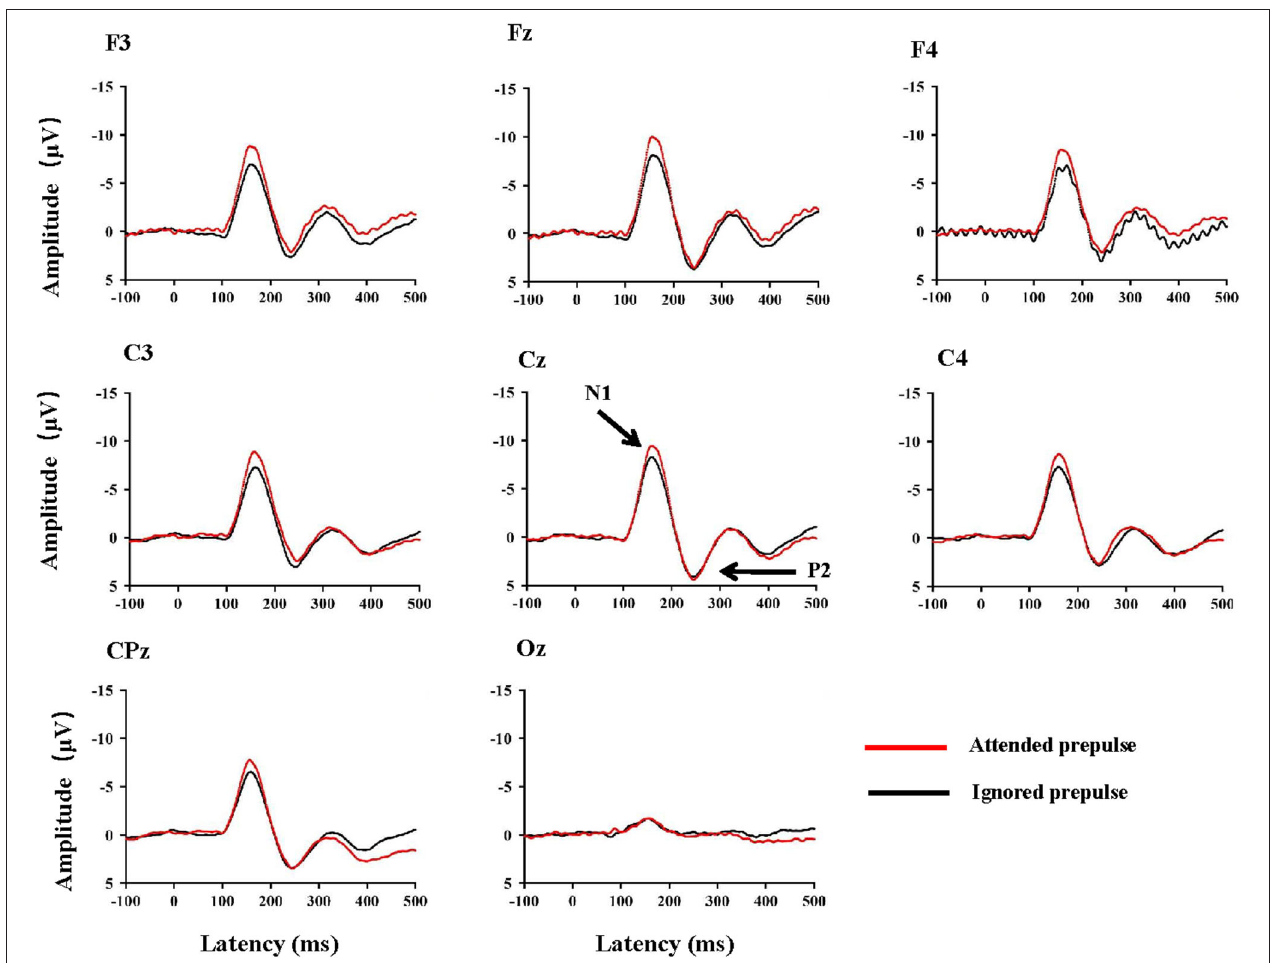
FIGURE 2 | Group-mean ERP waveforms at typical electrode sites F3, Fz, F4, C3, Cz, C4, CPz, and Oz in the attended prepulse condition and the ignored prepulse condition. Note that for the electrode sites surrounding the site Cz, the average amplitude to the attended prepulse was larger than that of the ignored